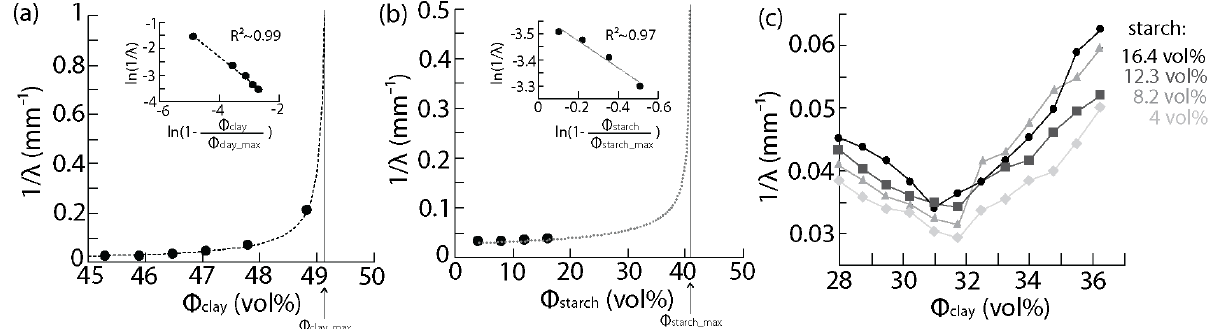
Figure 4. Effect of the matrix composition on the viscosity measured using the penetration depth method. ( a ) Inverse of the penetration depth 1 (cid:2019)(cid:3415) as a function of the solid content in clay (cid:2038) (cid:3030)(cid:3039)(cid:3028)(cid:3052) in clay–water mixtures; ( b ) 1 (cid:2019)(cid:3415) as a function of the solid content in starch (cid:2038) (cid:3046)(cid:3047)(cid:3028)(cid:3030)(cid:3035) in the starch hydrogels; ( c ) Plot of 1 (cid:2019)(cid:3415) as a function of (cid:2038) (cid:3030)(cid:3039)(cid:3028)(cid:3052) in clay–starch–water mixtures.